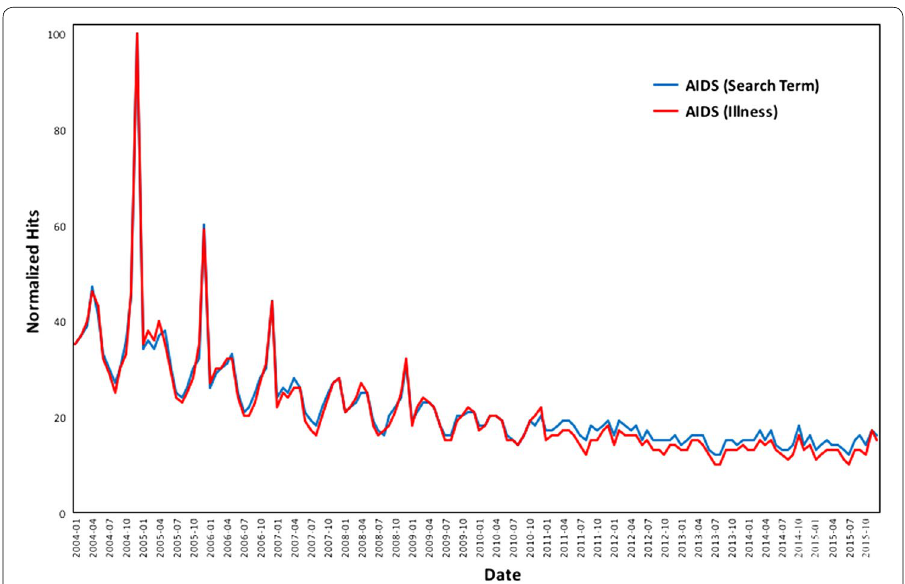
Fig. 1 Monthly Normalized Google Trends’ Data for ‘AIDS (Search Term)’ and ‘AIDS (Illness)’ from January 2004 to December